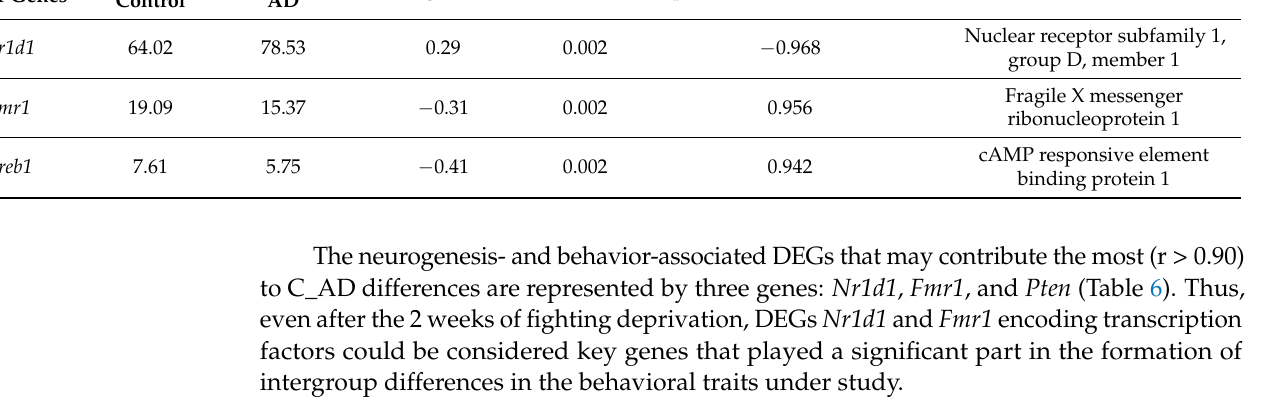
Table 6. Behavioral-trait–associated candidate genes that contribute the most to C_AD